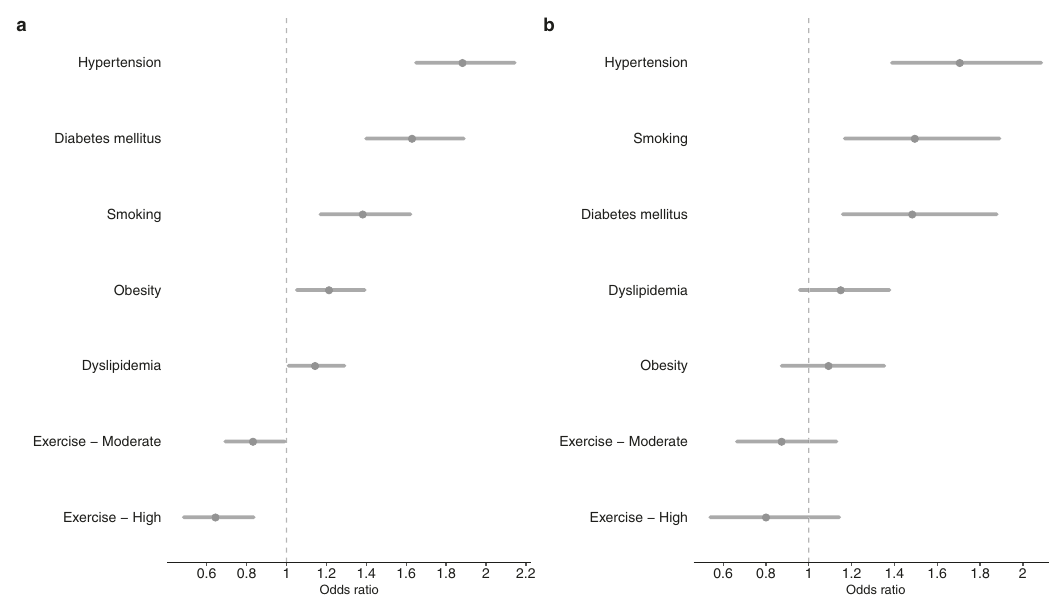
Fig. 3 Adjusted odds ratios (ORs) for the ELSA-Brasil cohort. The fi gure shows the adjusted ORs of the ECG-age being more than 8 years greater than the chronological age for risk factors. a All patients; and, b only for patients with normal ECG. The dots represent the adjusted ORs (by age and sex) and the horizontal lines represent the corresponding 95% CIs. HAS hypertension, DM diabetes mellitus, DLP